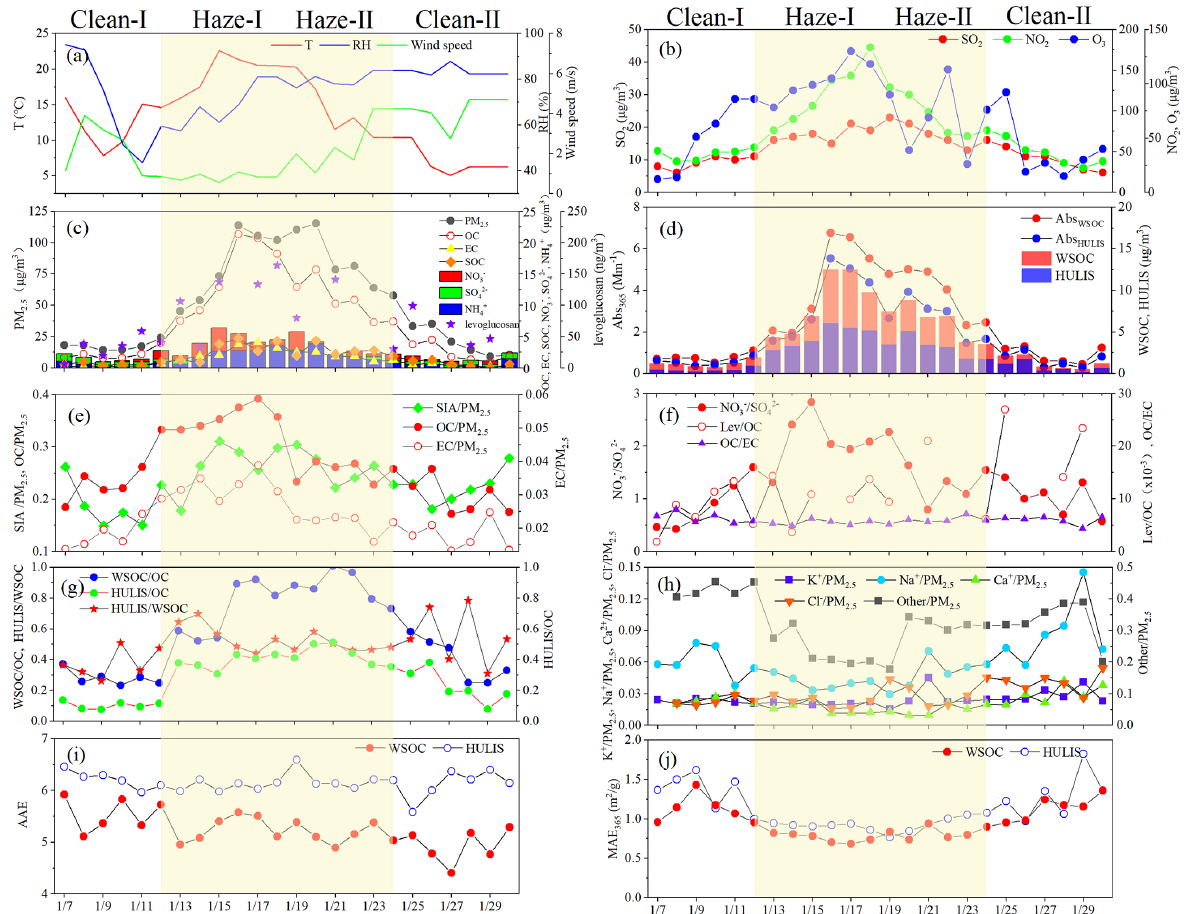
Figure 1. Temporal variation in meteorological parameters, concentrations of chemical composition, and optical properties (Abs 365 , MAE 365 , and AAE) of water-soluble BrC in the PM 2 . 5